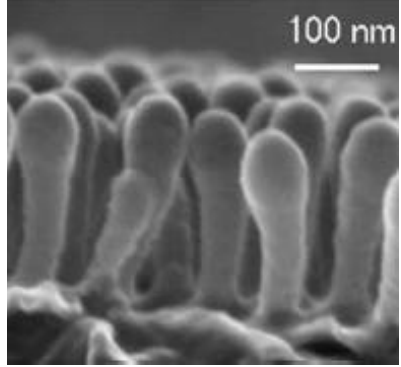
Figure 2. An SEM view of fabricated Au nanopillars